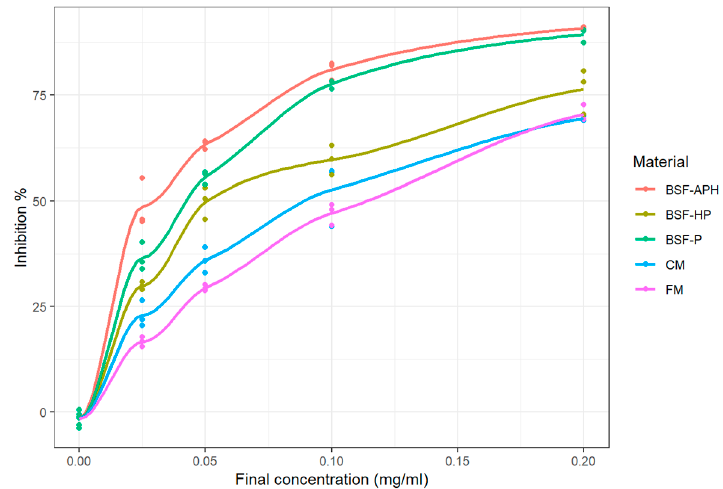
Figure 2. ABTS cation radical scavenging activity of PureeX TM (BSF-P), PureeX proTM (BSF-HP), ProteinAX proTM (BSF-APH), chickenmeal (CM), and fishmeal (FM) (n = 3).